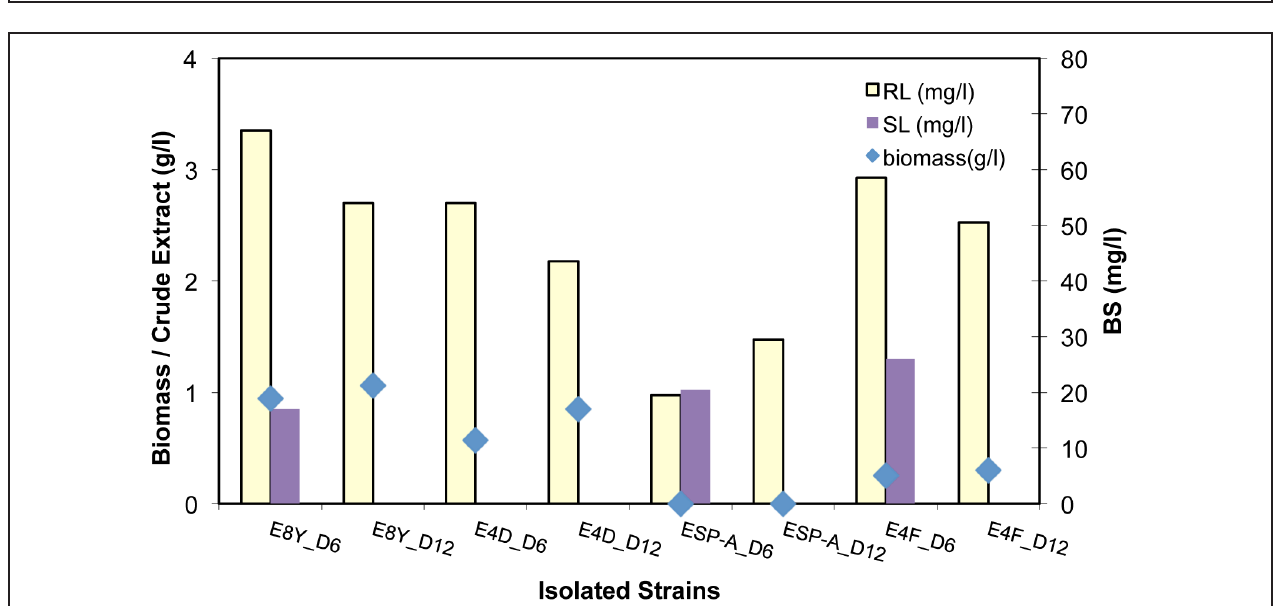
FIGURE 5 | Biomass (g/l), purified RL and SL concentration (mg/l) from the cultivation of strain E8Y, E4D, ESP-A, E4F for 6 and 12 days.